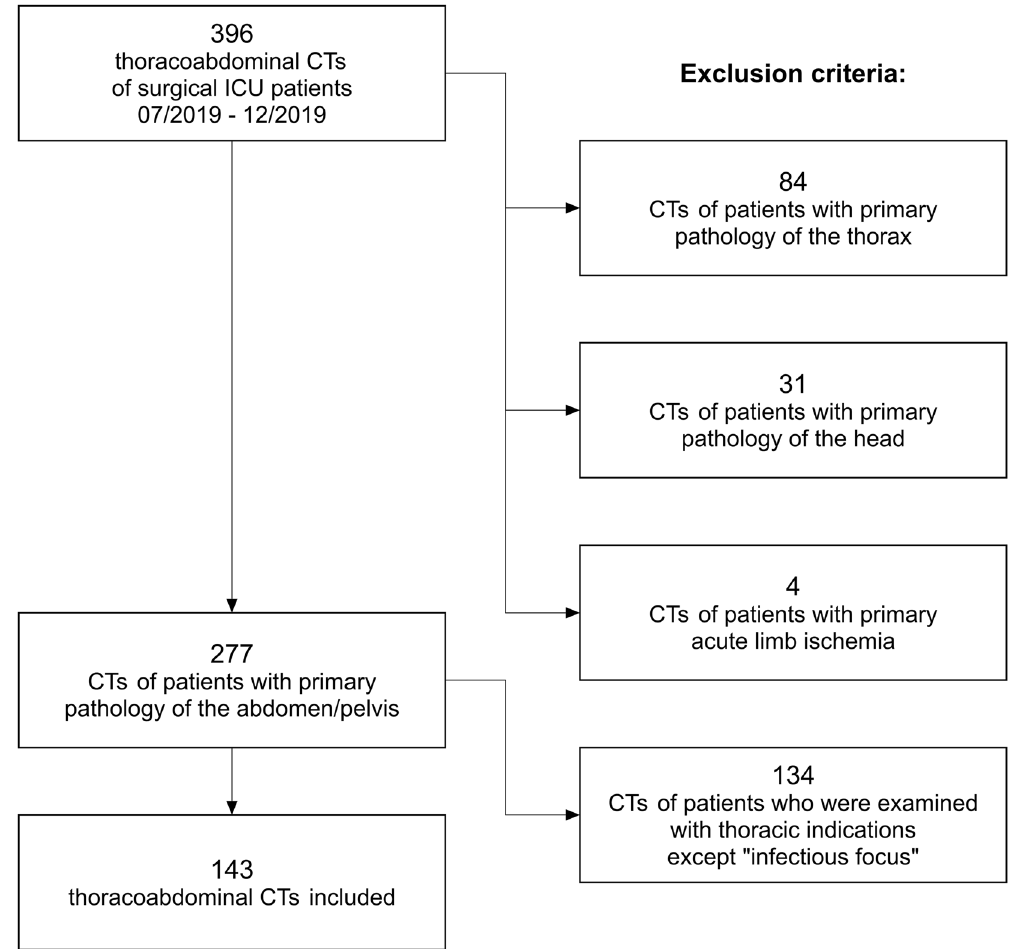
Fig.1 Study population and exclusion